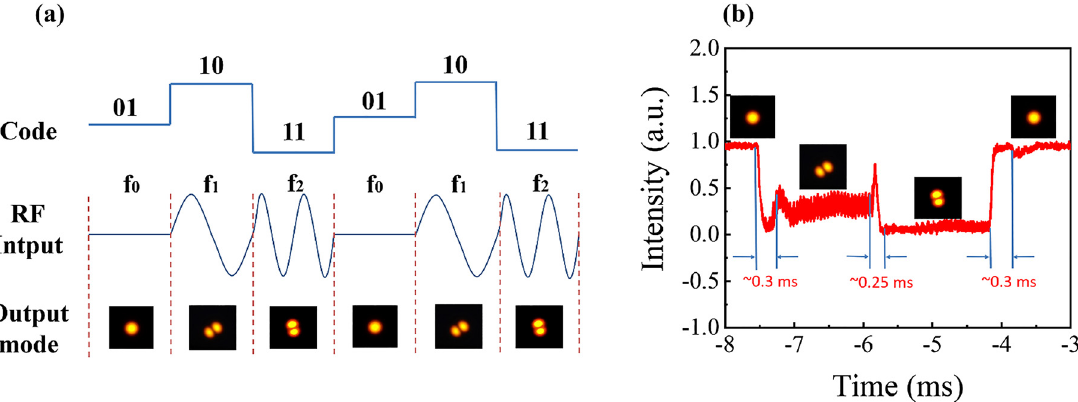
Figure 11: (a) The transversemode with real-timeswitching canbe modulatedby the AIFG. (b)The speedof mode switching from LP 01 modeto LP 11a (LP 11b